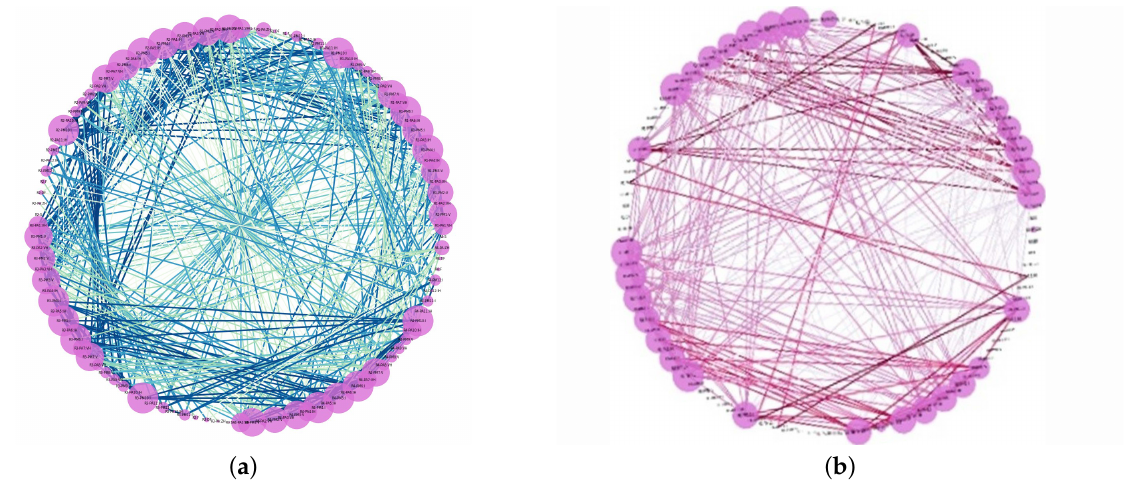
Figure 5. Power systems line maintenance correlation network map: ( a ) positive, and ( b ) negative correlation. The node names in these two figures are the